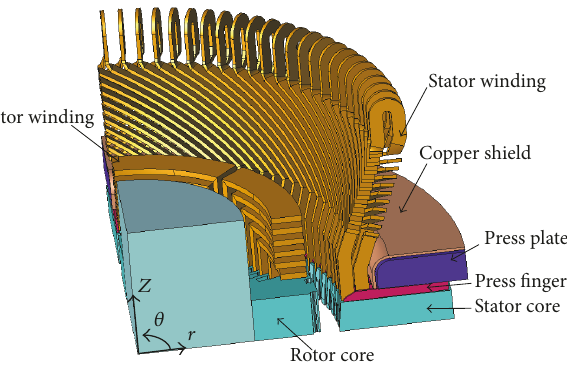
Figure 1: End region of a half-speed nuclear generator.